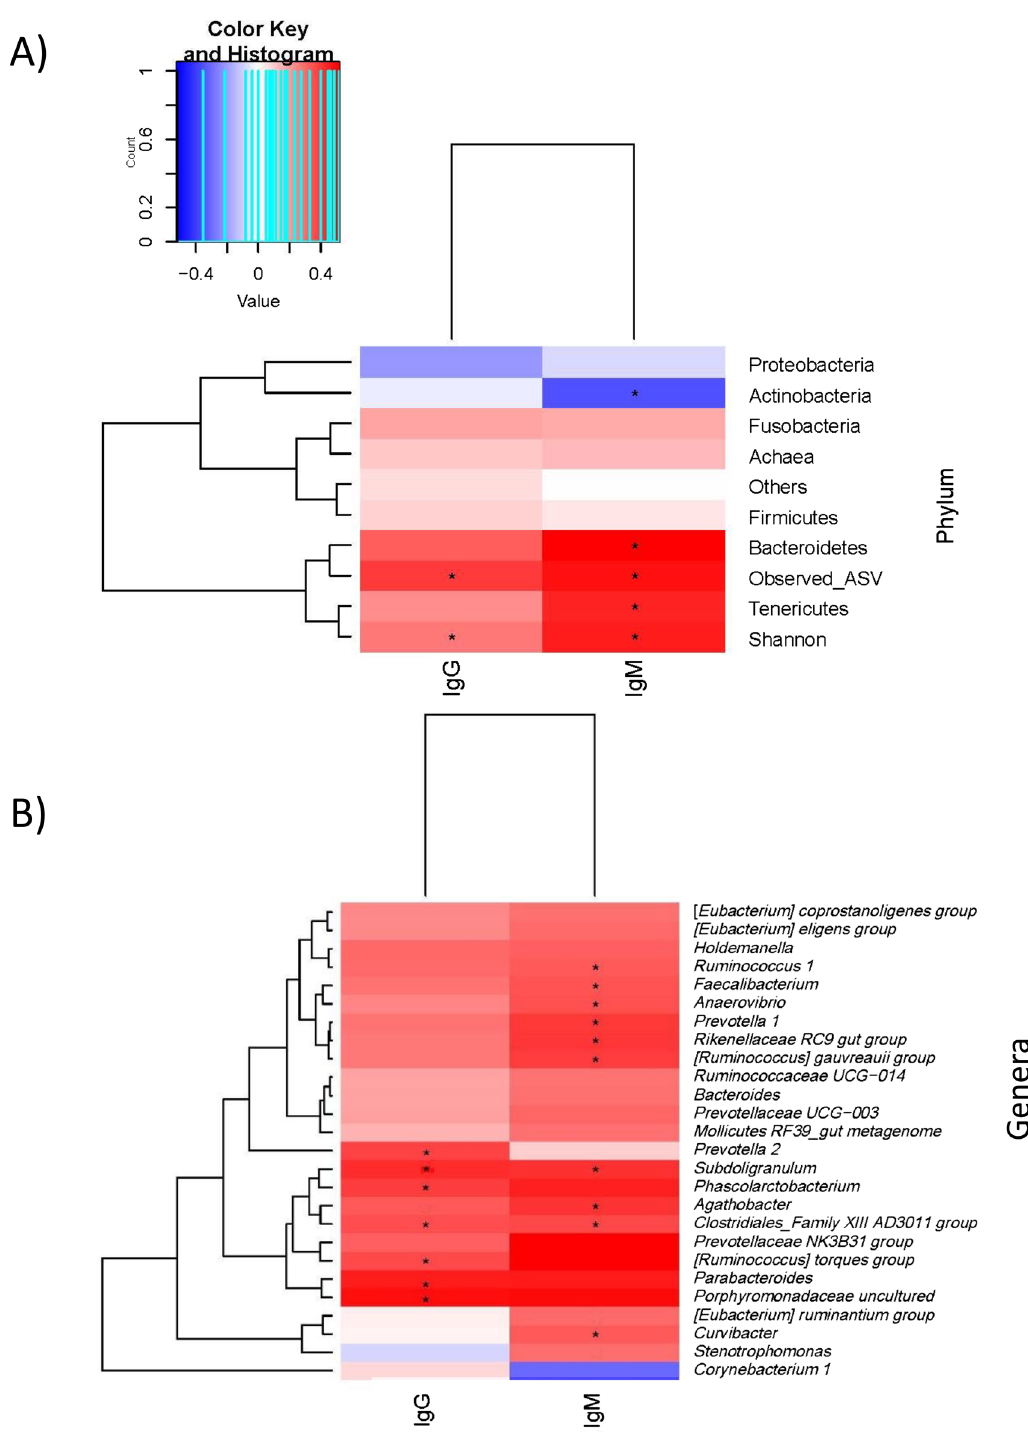
Figure 3. Several taxa of nasopharyngeal microbiota from pregnant women were related to the concentrations of both immunoglobulin M/A and G. Heatmap of the Spearman correlations between microbial taxa in the nasopharyngeal microbiome of pregnant women at the phylum ( A ) and genus levels ( B ) and the plasma concentration of immunoglobulin M/A (IgM/IGA) and G (IgG). At the phylum level, those phyla with a relative abundance lower than 0.5 and Cyanobacteria were grouped as “Others”. Only those genera with significant associations with at least one of the analyzed immunoglobulins are shown. The significant associations are marked with an asterisk. The color of the cell represents the positive (red) or negative (blue)